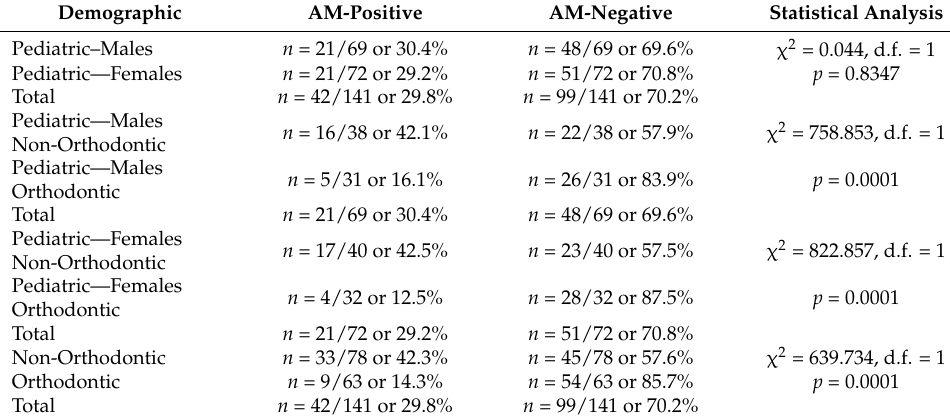
Table 4. Analysis of AM-positive and AM-negative pediatric samples.